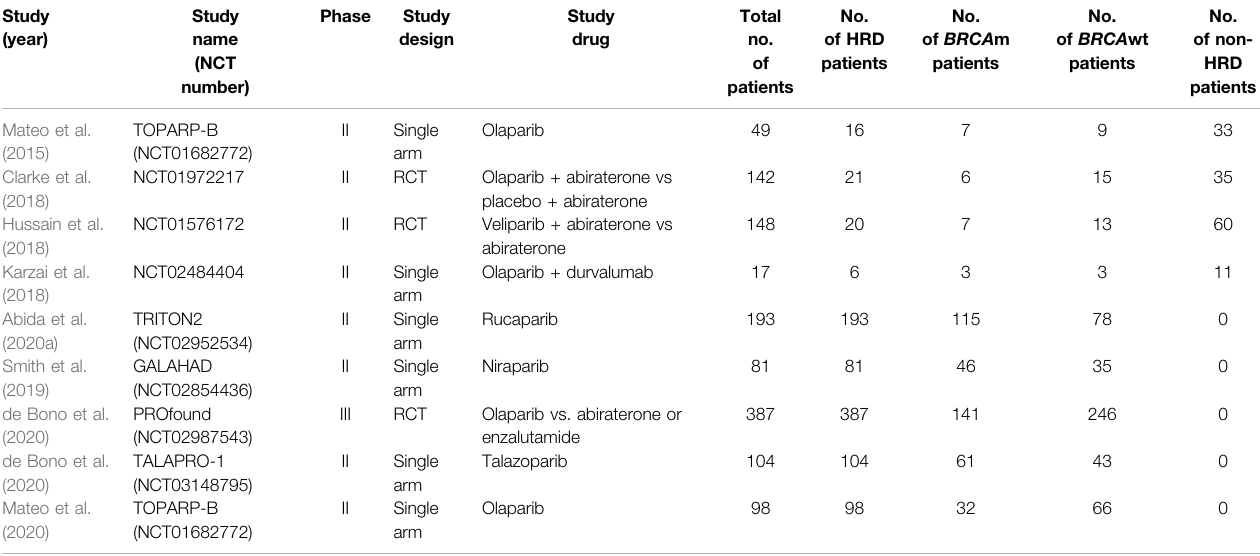
TABLE 1 | Characteristics of the eligible